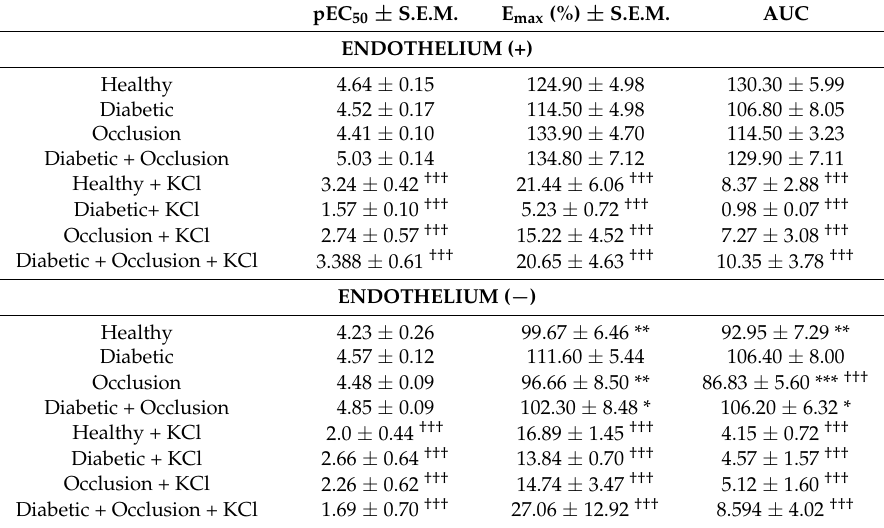
Table 1. Adenosine-induced relaxation in isolated rat femoral artery obtained from different animal groups/subgroups in the presence or absence of KCl (100 mM).